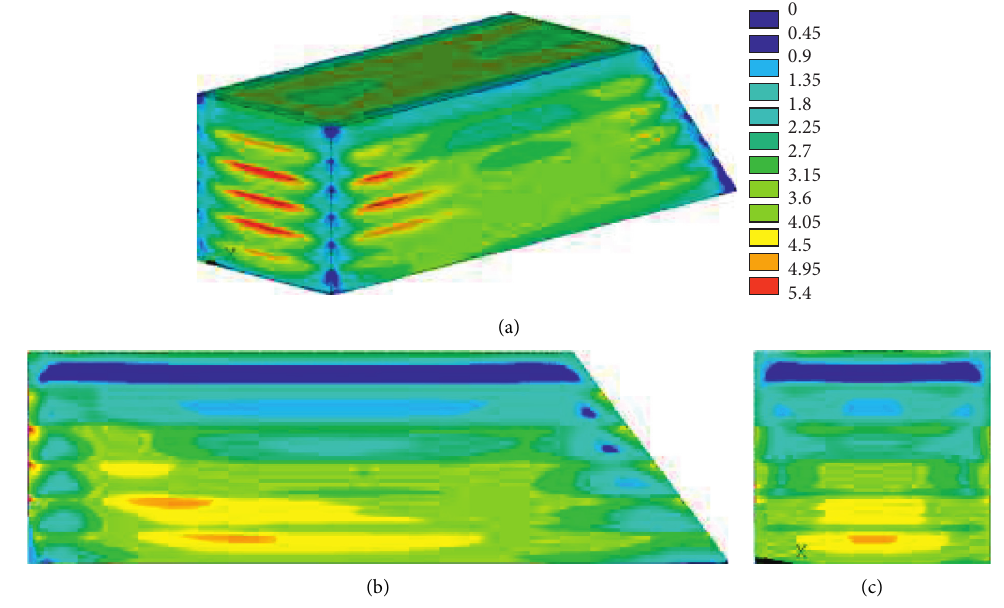
Figure 19: Stress envelope diagram of external surface, cross section, and longitudinal section of IC dam (MPa).